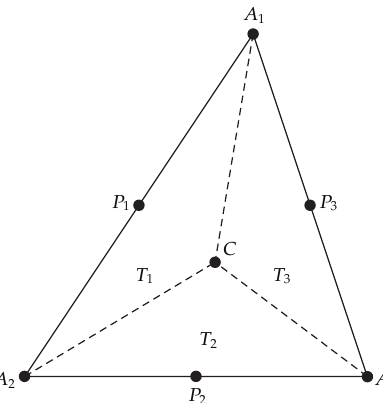
Figure 3: Triangular partition and its